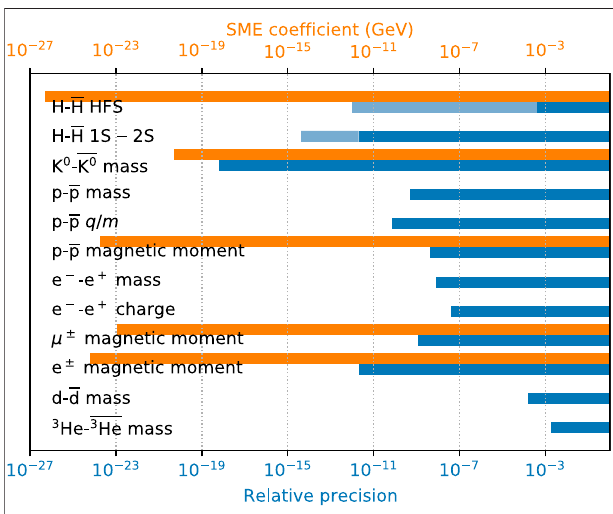
FIGURE1 | Lorentz and CPT violation breakdown canbe describedin a model-independent and general way via realistic Lagrangian effective fi eld theory.Theresultingeffective fi eldtheoryframeworkisknownastheStandard Model Extension (SME). In this fi gure the relative experimental precision and SME coef fi cients for various quantities is shown [3]. Dark blue: existing experimental values, orange: SME coef fi cient. Courtesy of Eberhard